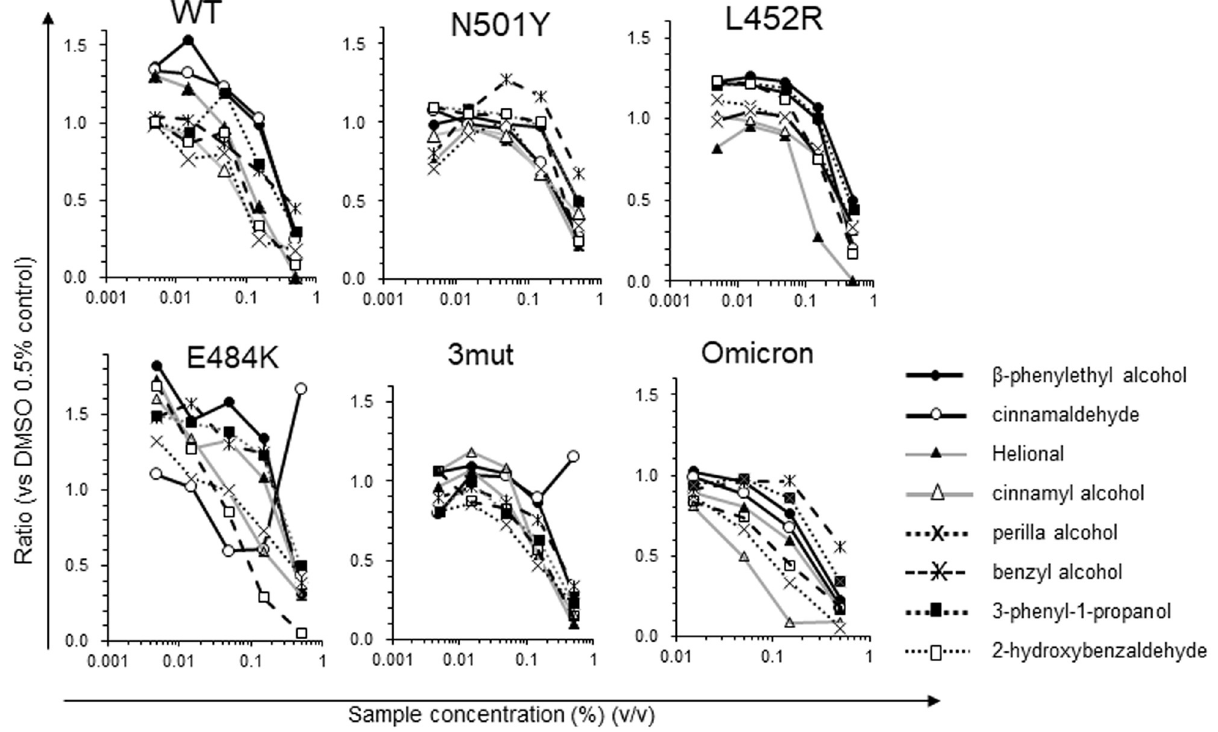
Fig 3. Dose dependency of flavor/fragrance compositions for the inhibition of the binding of variant vRBDs to hACE2. Five concentrations (0.5%, 0.15%, 0.05%, 0.015%, and 0.005%) of each flavor/fragrance composition were evaluated in 96-well plates. 0.5% DMSO was the solvent for each flavor/ fragrance composition and was used as the negative control (= 1.0). Data presented are representative of two or more experiments.